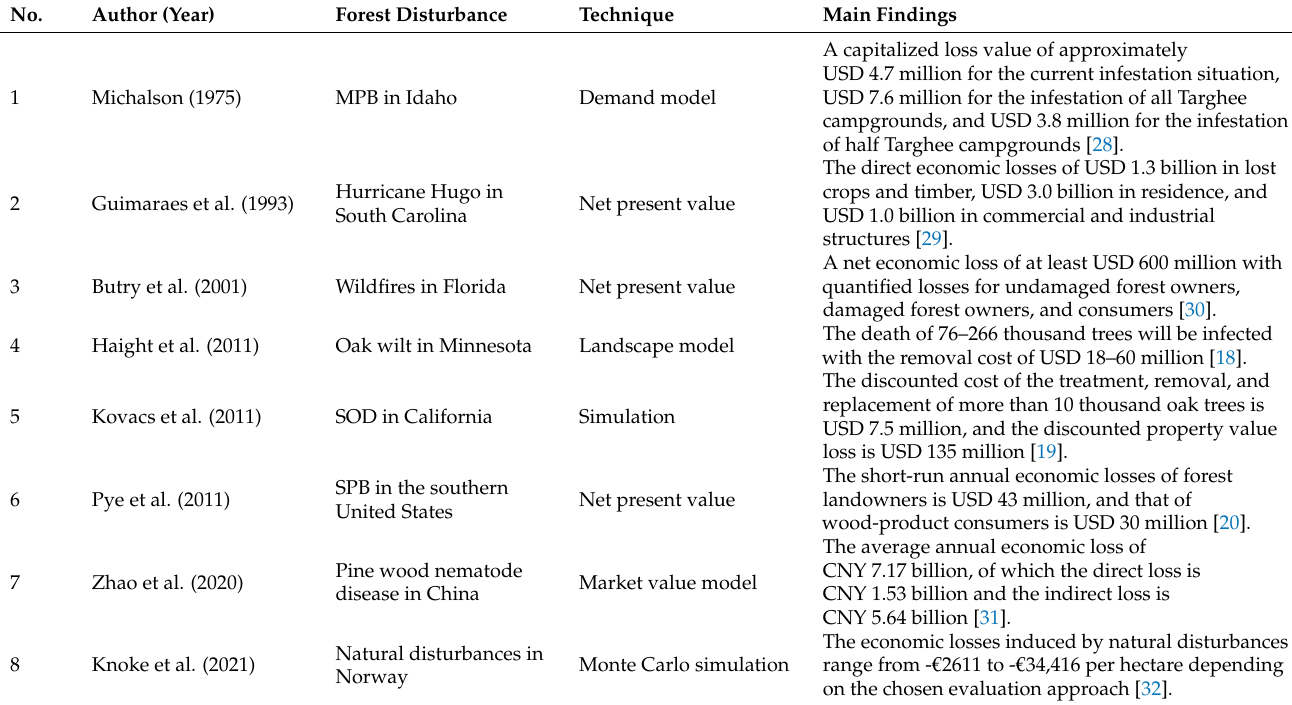
Table 3. Summaries of literature using the theoretical